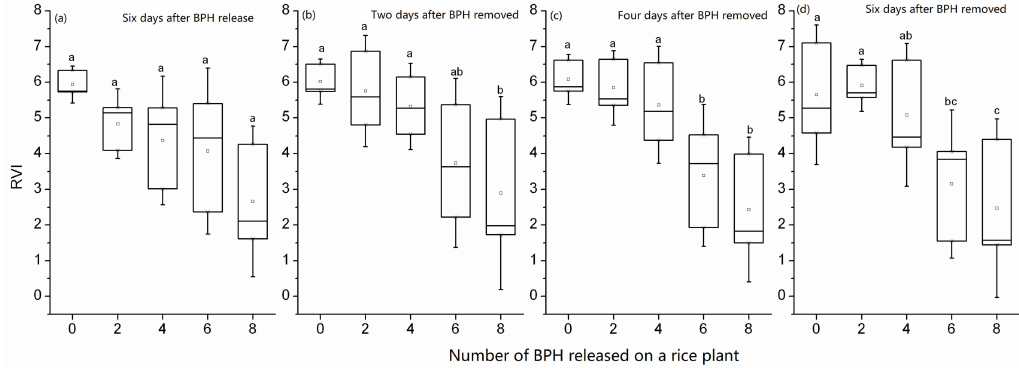
Figure 5. RVI 746/670 of rice leaves exposed to 0–8 second-instar BPH nymphs for six days ( a ) and 2–6 days after BPH exposure ( b , c , d ). In the box plot, the box represents the 25th and 75th percentiles; whiskers represent the minimum and maximum values; the line in box represents the median percentile; the open circle in a box represents the mean. The different letters above the box plots show significant differences in the RVI 746/670 means among different numbers of BPH at p = 0.05 level.